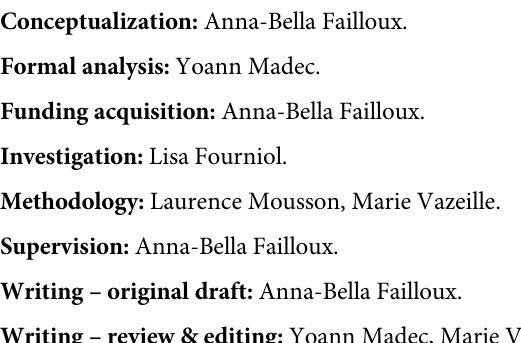
S1 Table. Detection sensitivity of CHIKV RNA copies by qRT-PCR. 50 μ L of different dilu- tions of viral particles were processed for RNA extraction and quantification of RNA copies by qRT-PCR. S2 Table. Quantities of RNA copies detected on cards impregnated with honey solutions (10%, 20%, 50%) and examined at different days (1, 2, 3 and 7) after spotting different quantities of CHIKV particles. Two replicates (R1 and R2) were performed. S3 Table. Comparison of transmission efficiencies between mosquito species, day post- exposure and treatments (logistic regression